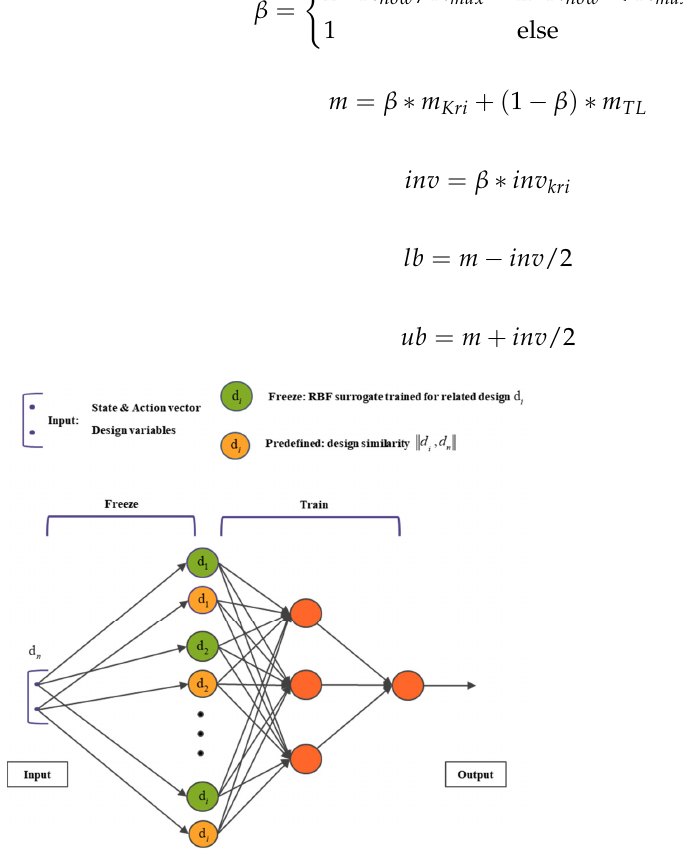
Figure 7. Network structure of the knowledge transfer surrogate. Algorithm 1 Pseudo code for initial stage